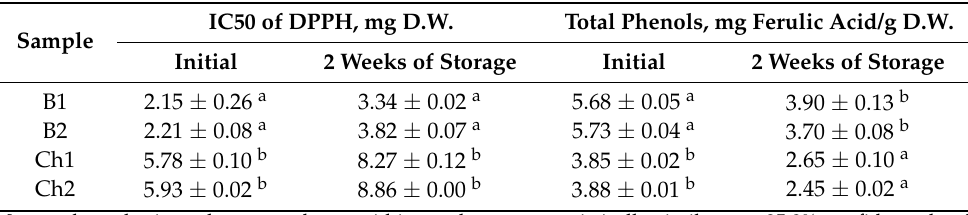
Table 3. Antioxidant activity of the fermented vegetable products.